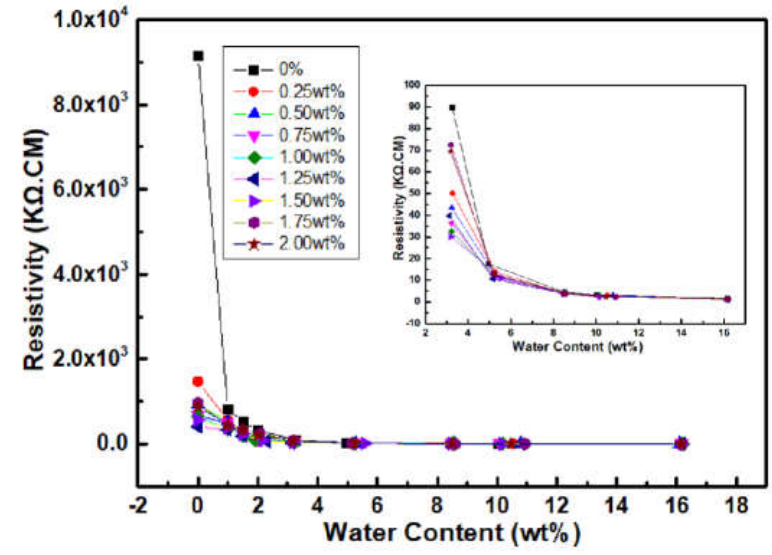
Figure 11. Resistivity of WPPy/cement composites with different water contents.